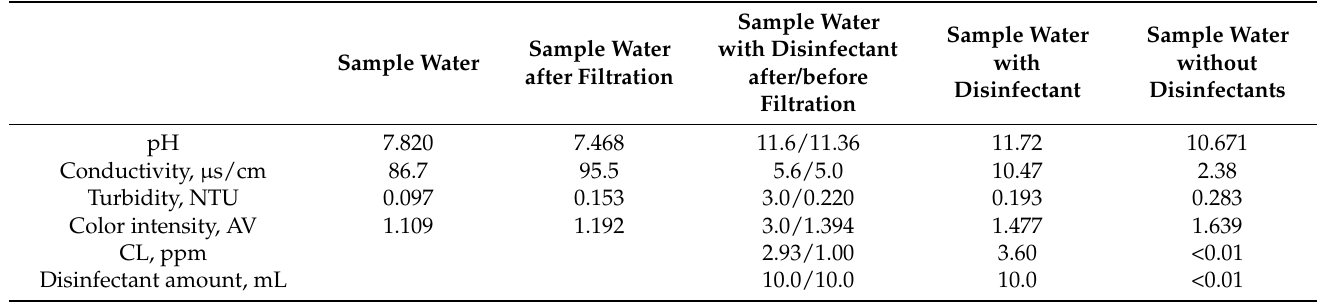
Table 6. Pollution indicators of sample water contaminated with sodium